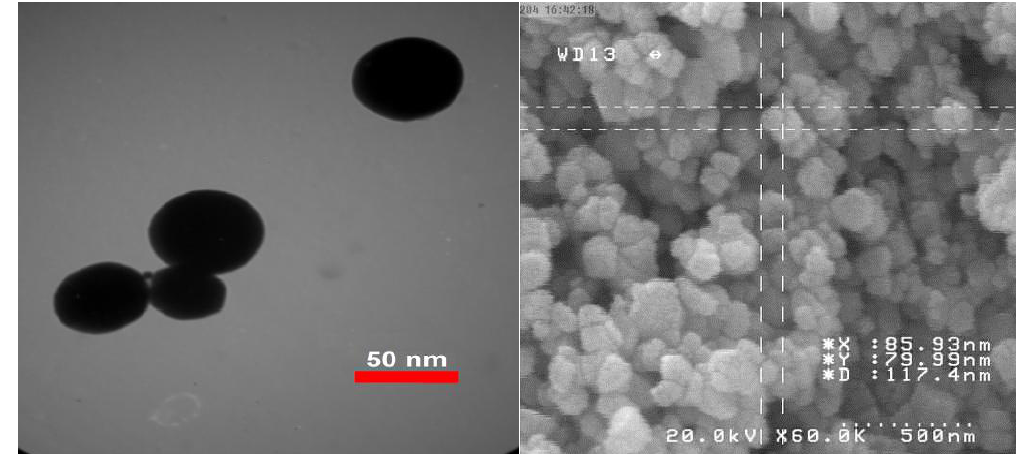
Figure 1. Transmission electron microscopy (TEM ( (left) and scanning electron microscopy (SEM) (right) images of tested CuO